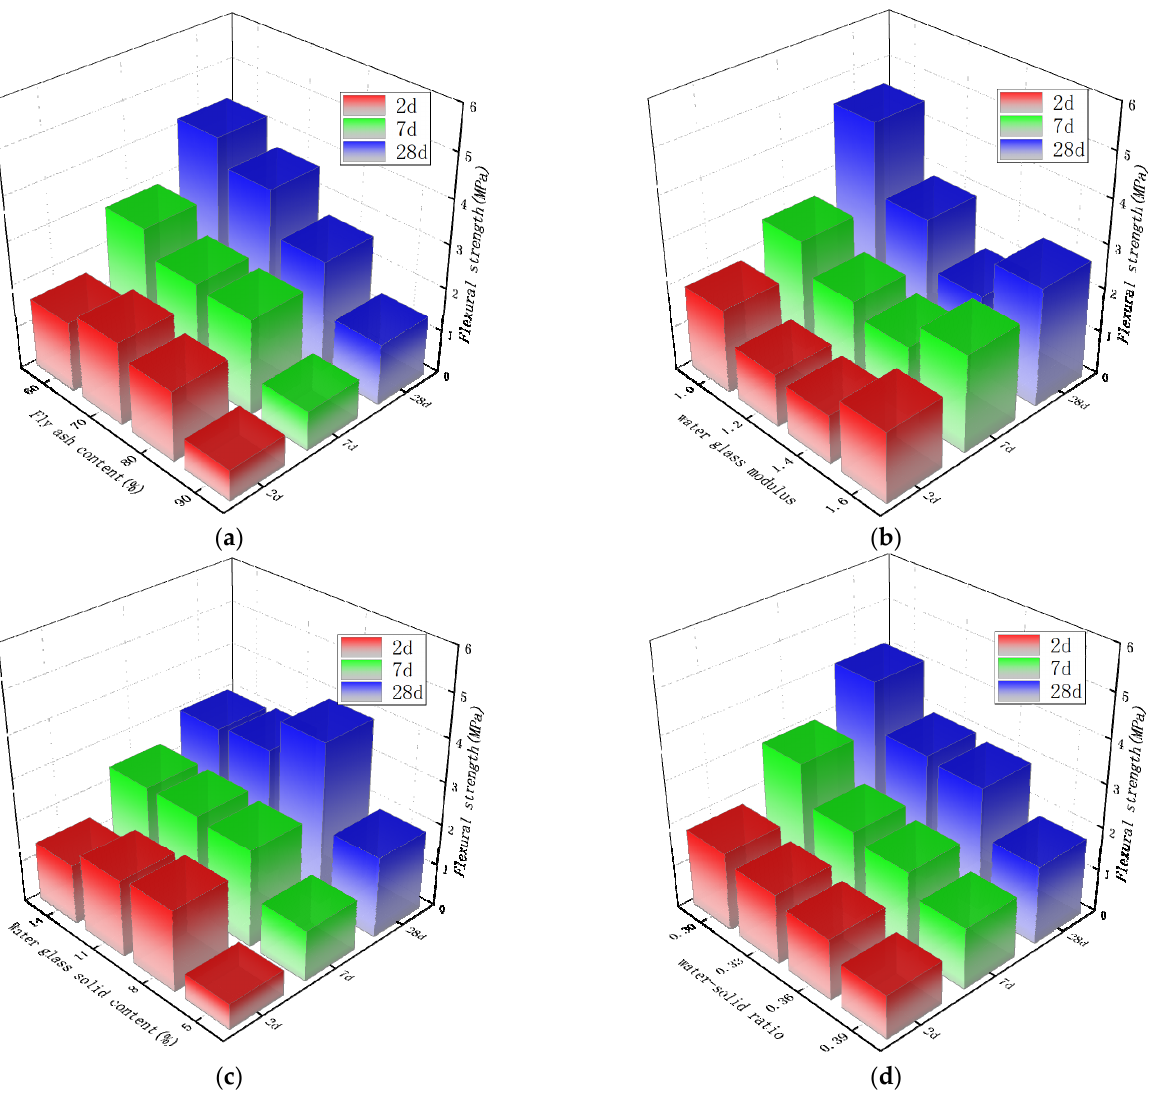
Figure 4. Influence of various parameters on the flexural strength of composite gelling system. ( a ) Influence of fly ash content on flexural strength. ( b ) Influence of water glass modulus on flexural strength. ( c ) Influence of water glass solid content on flexural strength. ( d ) Influence of water–solid ratio on flexural strength.